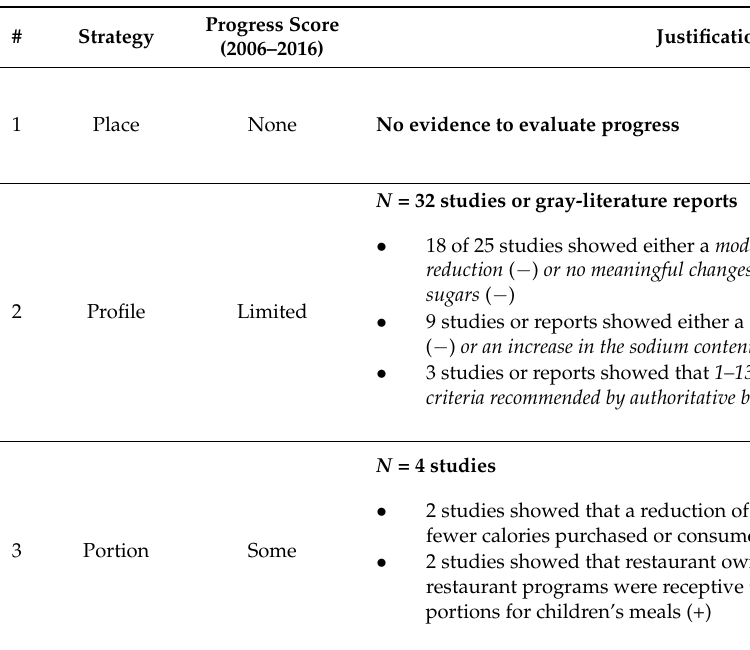
Table 5. Progress scores and priority actions suggested for the U.S. restaurant sector to nudge American children, adolescents and parents toward healthy food